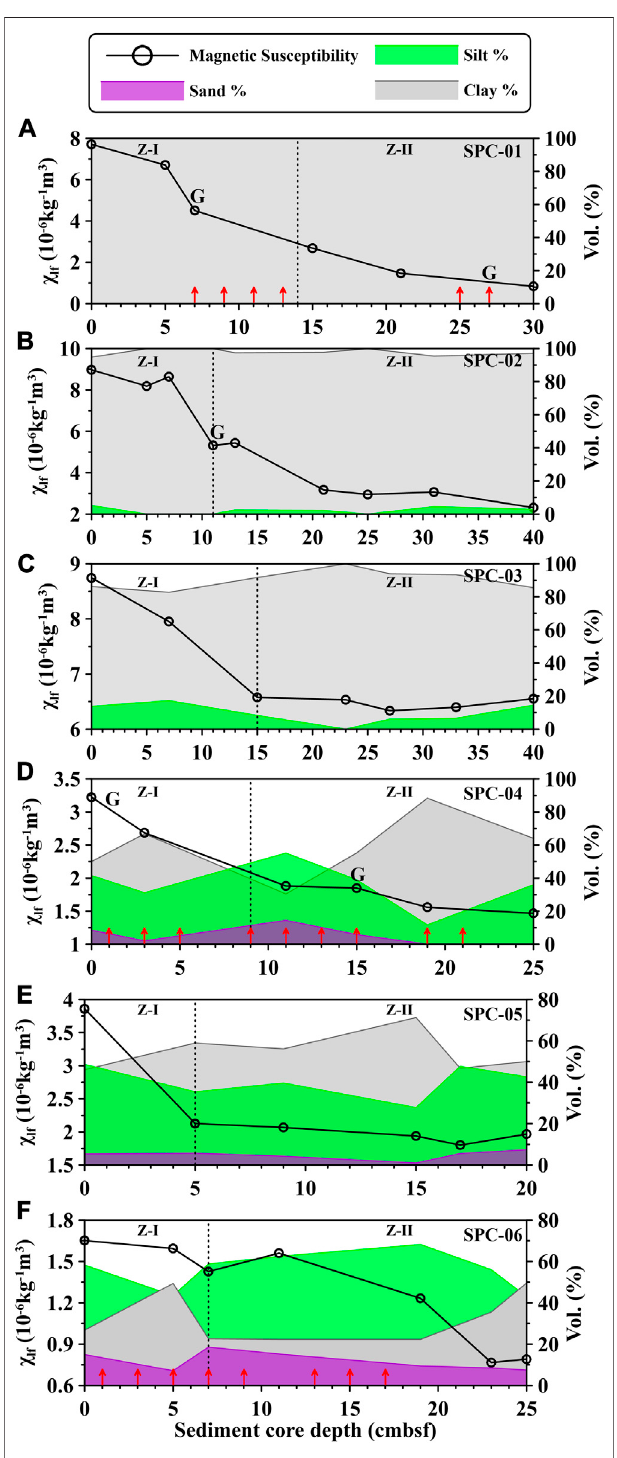
FIGURE 10 | (A – D) : Bivariate scatter plots of magnetic parameters magnetic susceptibility ( χ lf), saturation isothermal remanent magnetization (IRM 1T ), IRM 1T / χ , S-ratio, ARM/IRM 1T and mean grain size for spade cores (SPC-01 to SPC-06) from active (SSD-45/Stn-4) and gravity core (GC- 02) from relict seep site (SSD-45/Stn-11) in the Krishna-Godavari (K-G) basin, Bay of Bengal. The gray arrows are used to highlight the trends in plots.